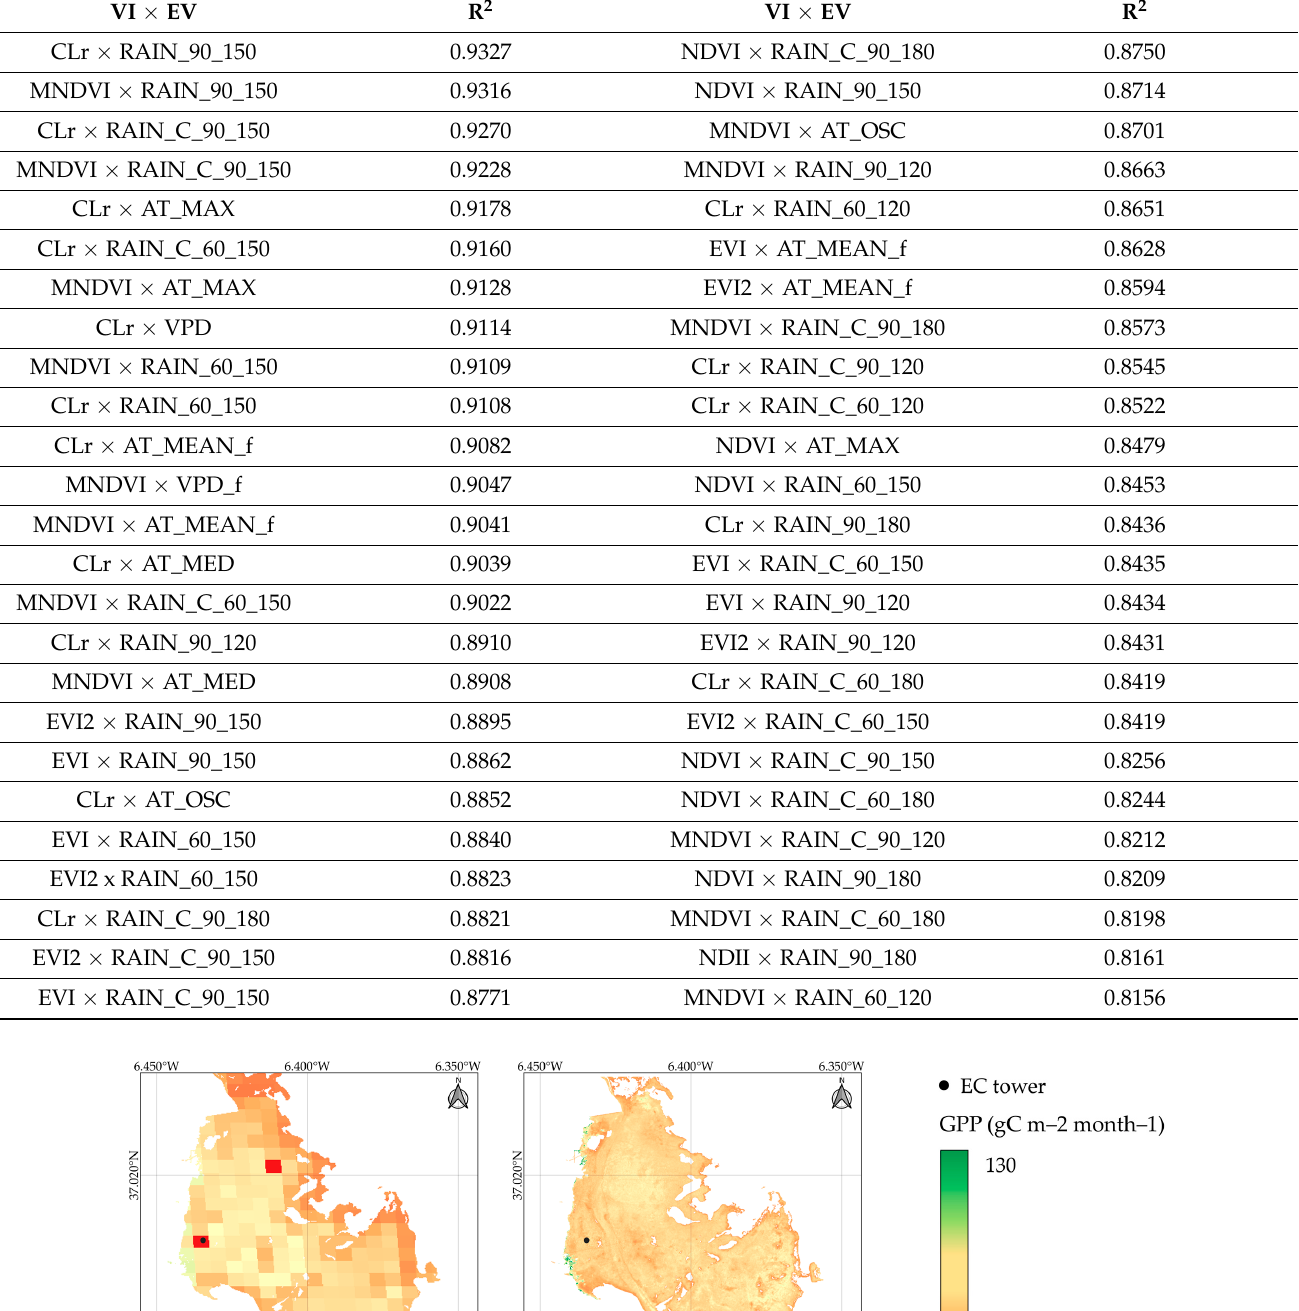
Table A2. Coefficient of determination of the first fifty VIs and environmental variables combinations showing higher correlation with ground measurements of GPP.